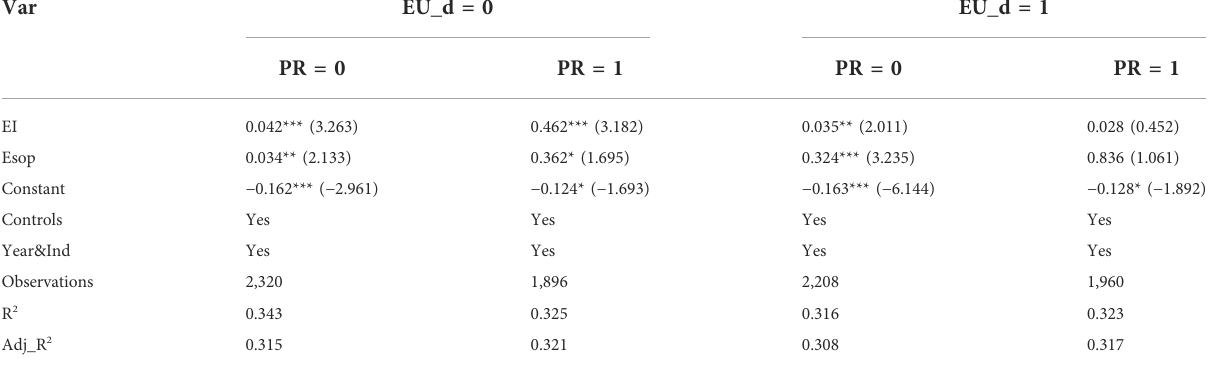
TABLE 7 Model 4) grouping test of property right